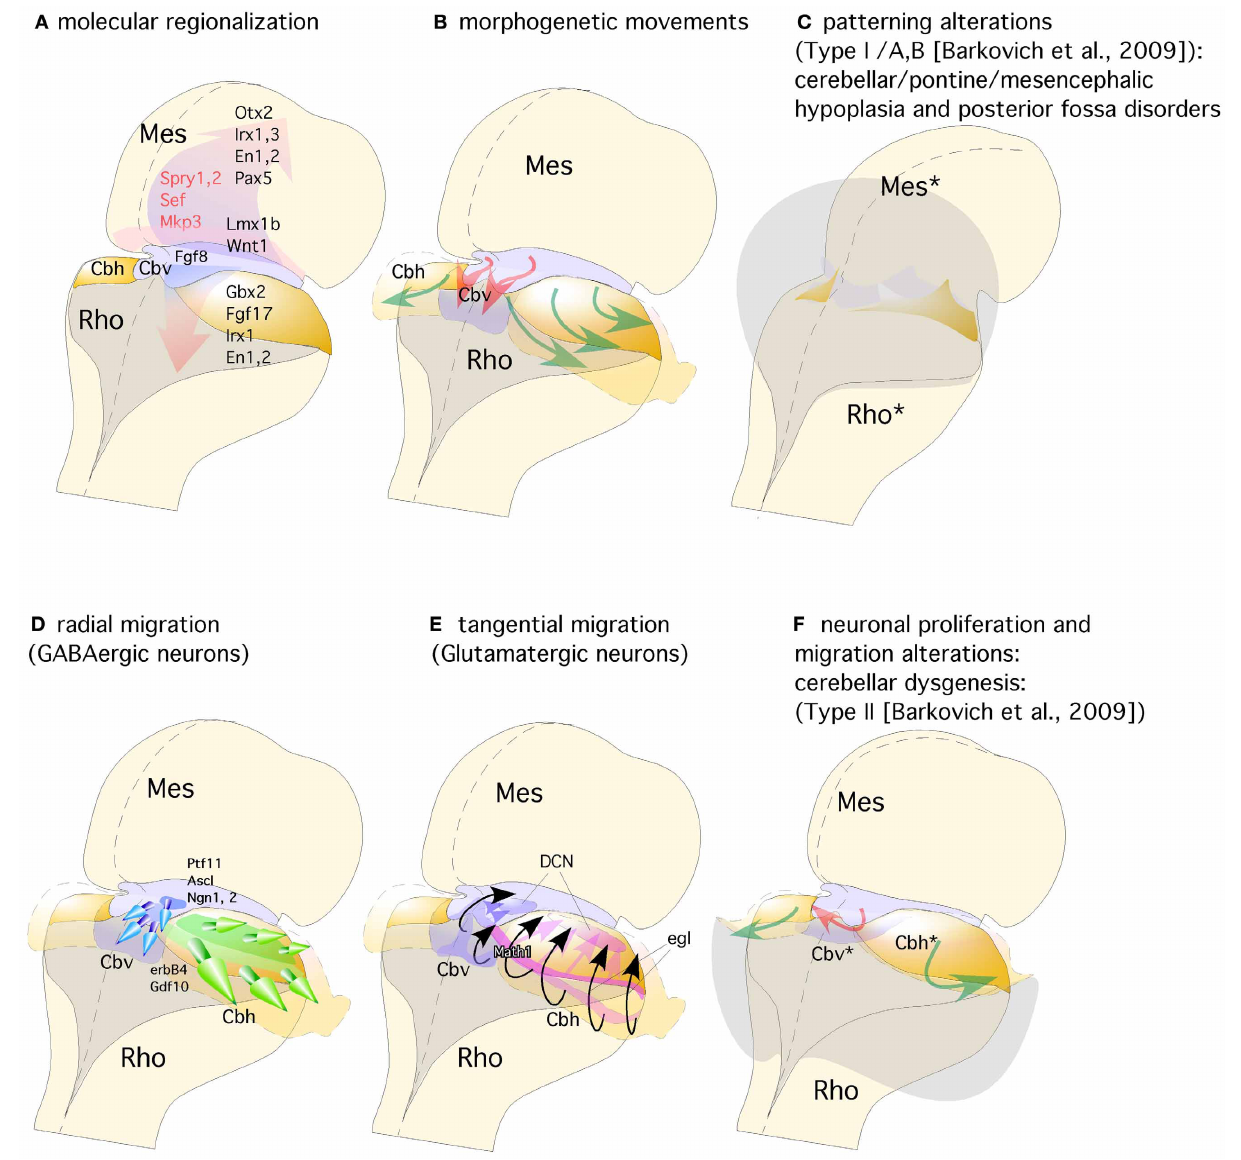
expression) can result in cerebellar (Rho ∗ ) and mesencephalic (Mes ∗ ) hypoplasia due to a strong increase of cell death with posterior fossa disorders and fourth ventricle dilatation (gray shadow). (D) Radial migration of GABAergic neurons in the cerebellar vermis (Cbv; blue arrows) and hemispheres (Cbh; Green arrows). (E) Rhombic lip specification is regulated by Math1 . Tangential migration of glutamatergic neurons of the deep cerebellar nuclei (DCN) and granule cells (egl) are represented by pink and black arrows, respectively. (F) When normal development of cortical cerebellar cells is disrupted, the structural phenotype is classified as cerebellar dysgenesis (Cbv ∗ and Cbh ∗ ), with enlargement of the fourth ventricle and reversion of cerebellar-choroidal junction